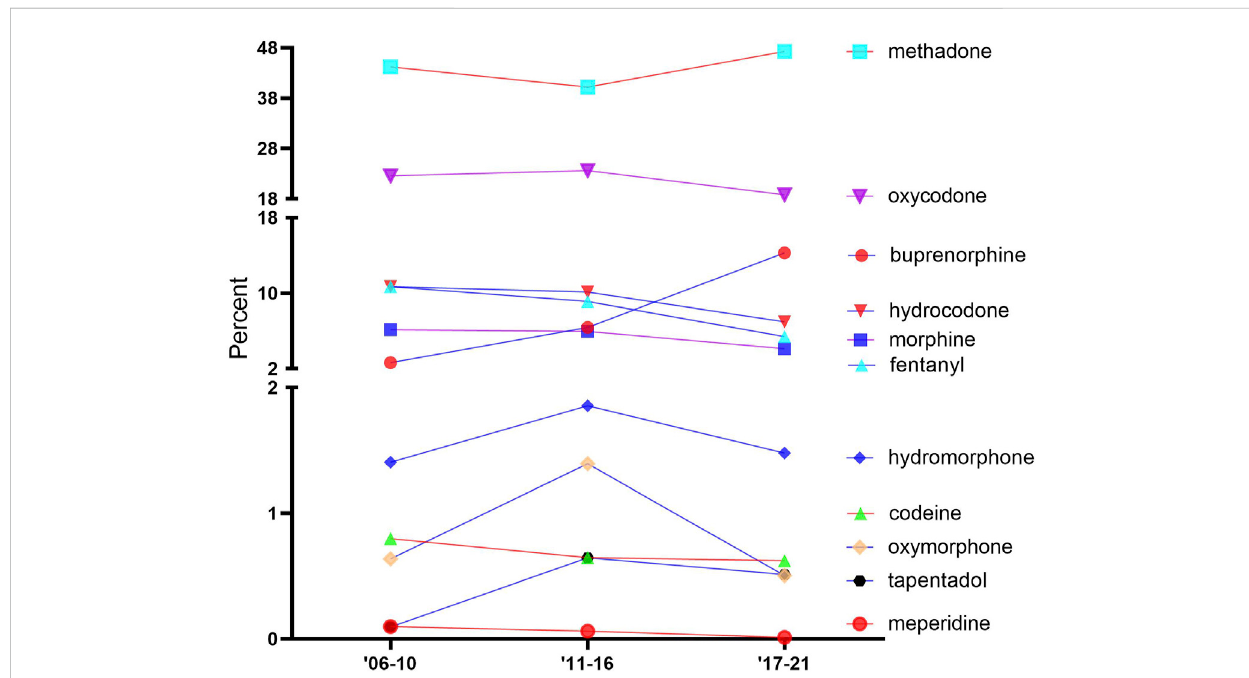
FIGURE 2 Percentage of the total morphine mg equivalent (MME) of the distribution of 11 prescription opioids, as reported by the Drug Enforcement Administration ’ s Automated Reports and Consolidated Orders System (ARCOS) over time.